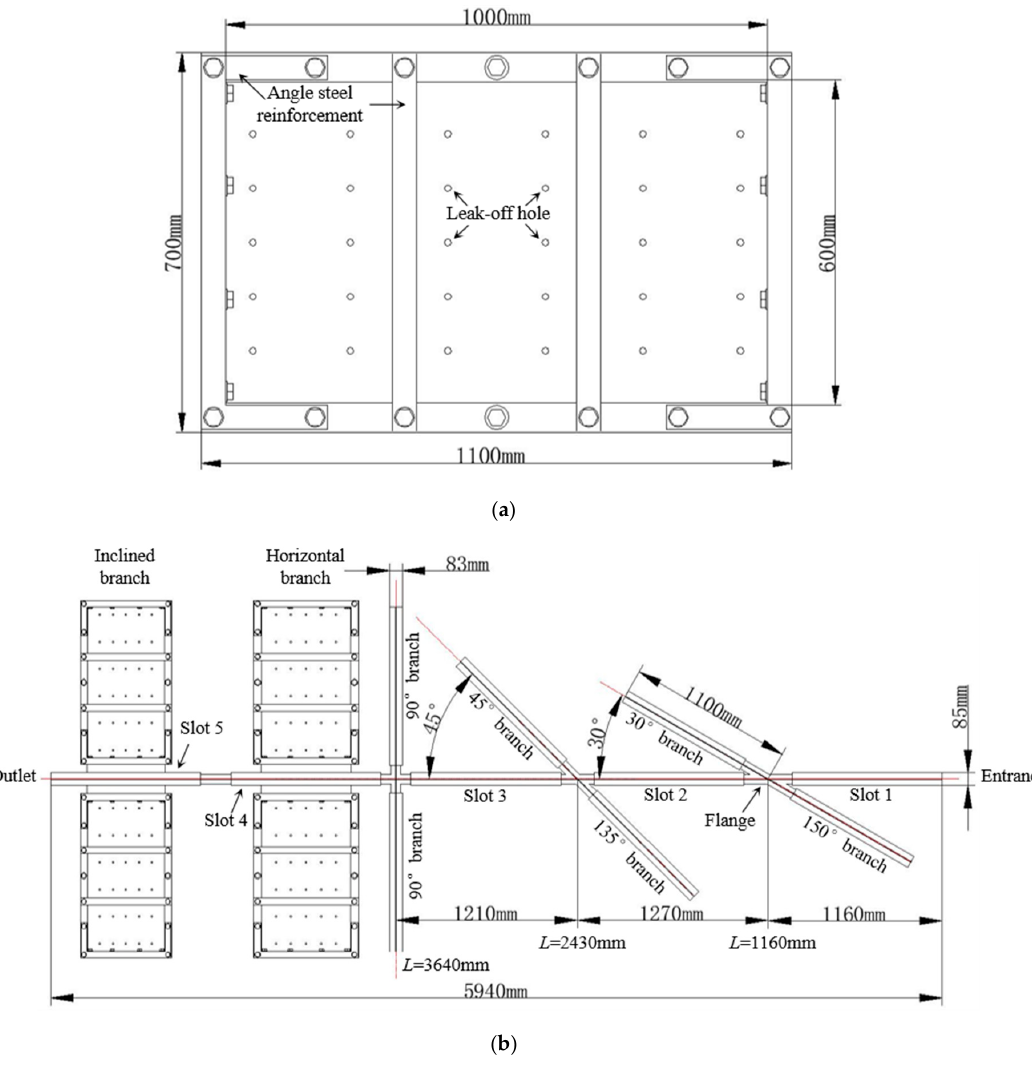
Figure A1. Design drawing of the slot system, ( a ) schematic of a single slot, ( b ) top view of the fracture system.